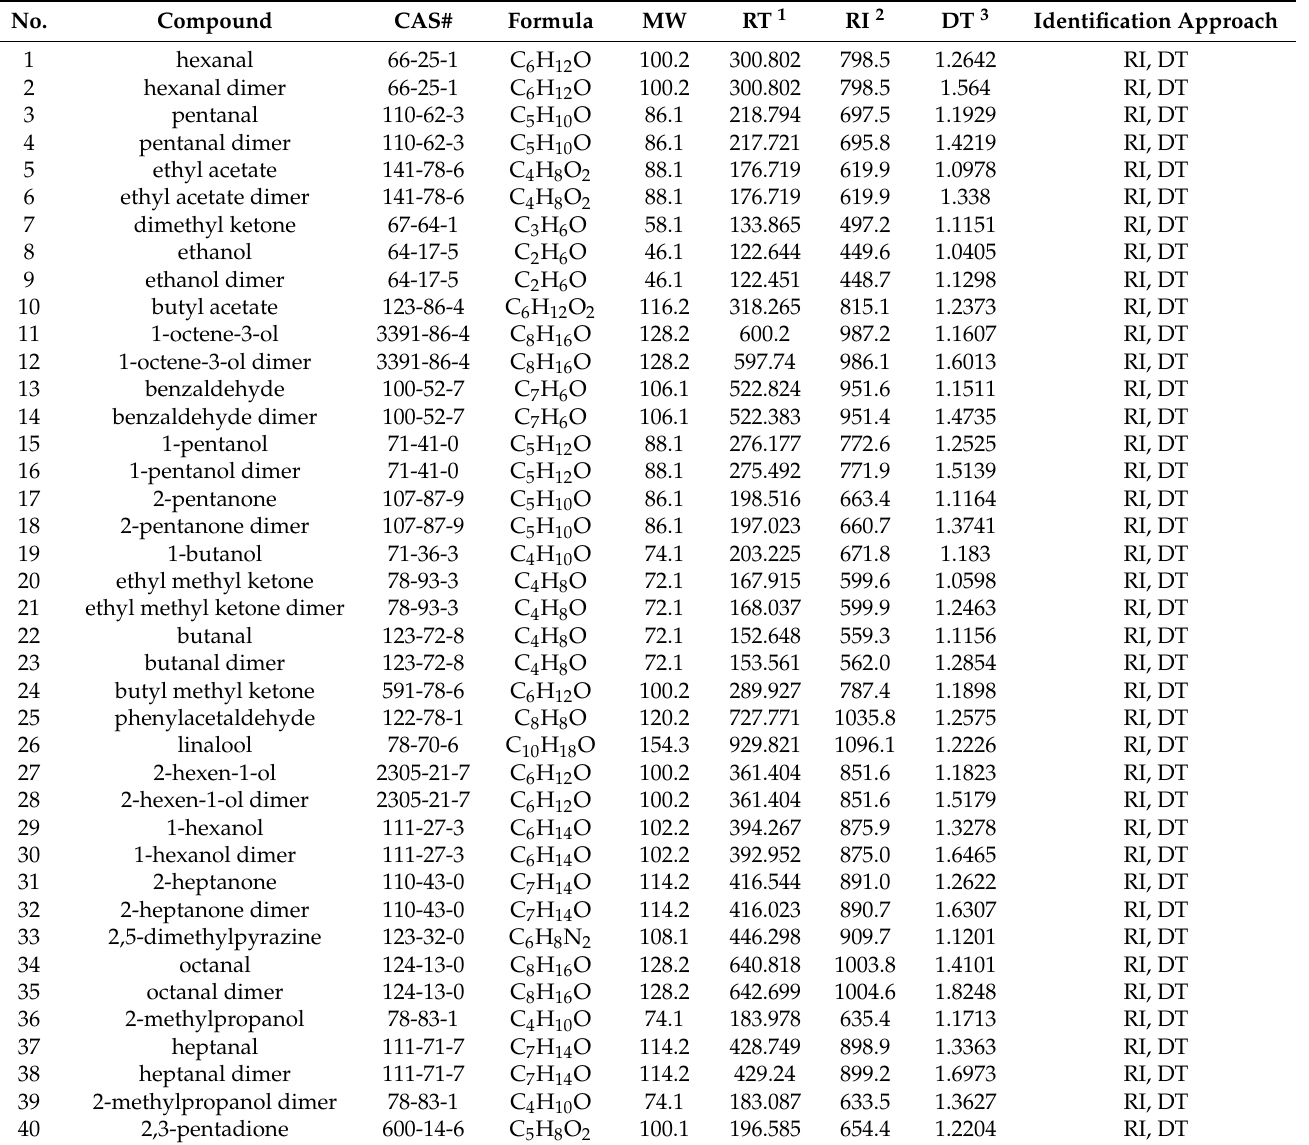
Table 1. GC-IMS integration parameters of volatile compounds in T. matsutake samples under different processing conditions.